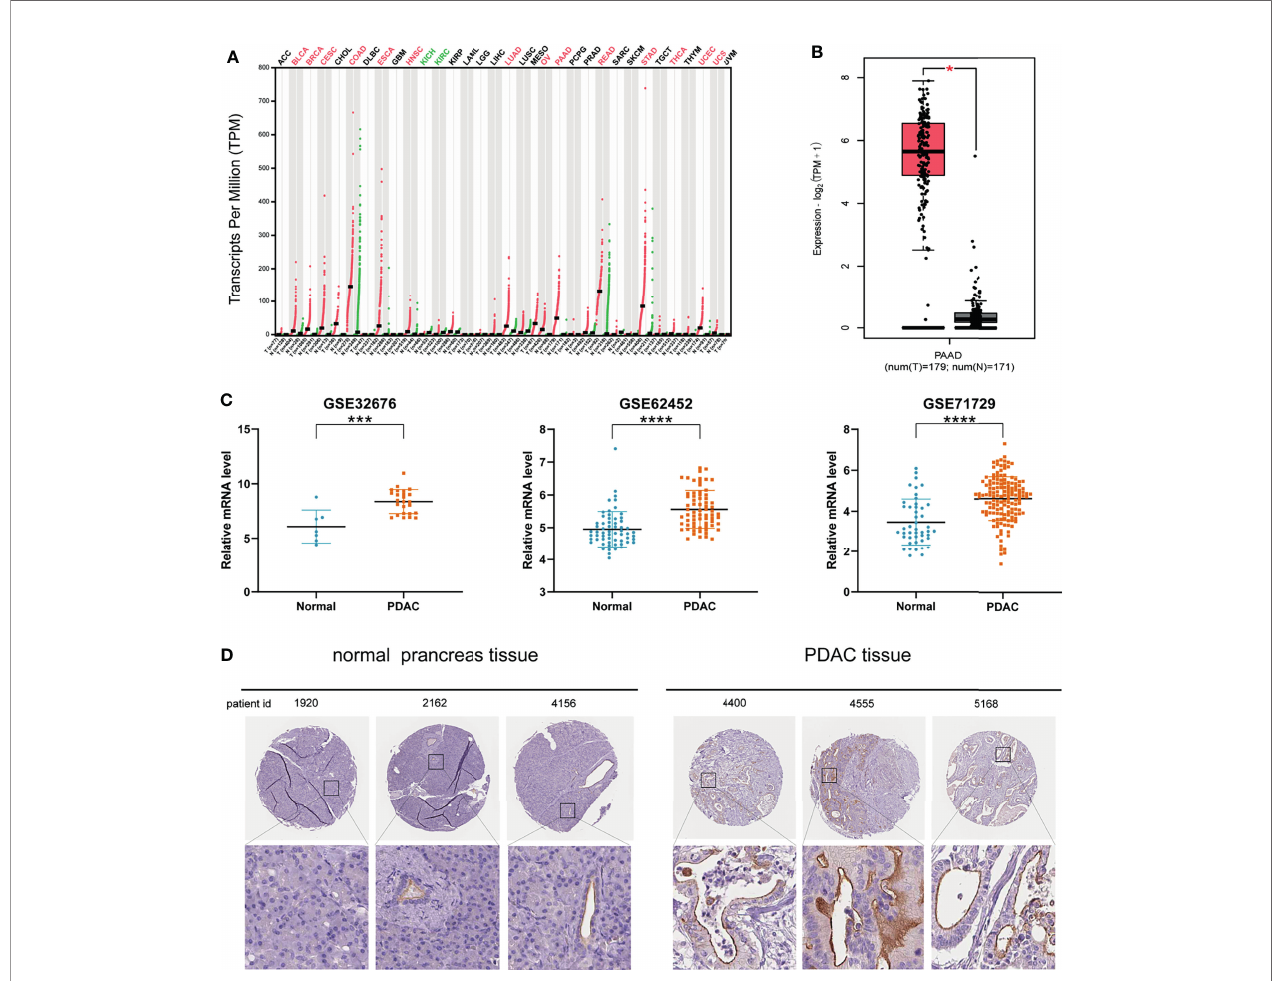
FIGURE 1 | MISP expression is increased in PDAC tissues based on GEPIA 2 and GEO datasets. (A) MISP was signi fi cantly upregulated in various tumors. (B) Expression level of MISP in PAAD in comparison with the normal group as analyzed by the GEPIA 2 database. (C) The GEO datasets (GSE32676, GSE62453 and GSE71729) showed that the MISP mRNA expression is upregulated in PDAC tissue. (D) Representative immunohistochemistry staining images for MISP in PDAC and normal tissue from the HPA database. *P<0.05, ***P<0.001,